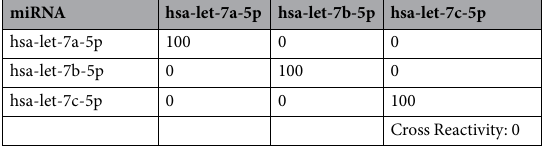
Table 2. Percentage of cluster cross-reactivity of let-7 miRNA family members.